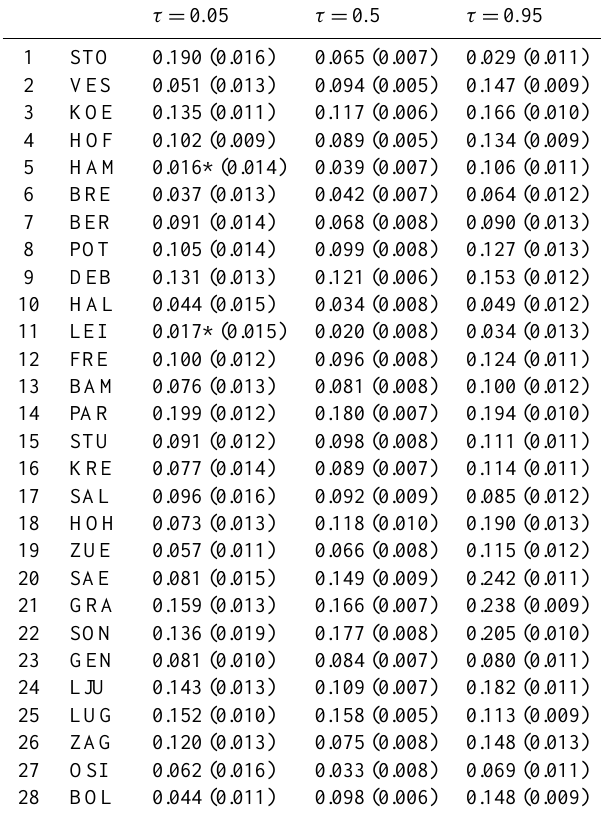
Table 2. Quantile slopes ( ◦ Cdecade − 1 ) and corresponding stan- dard errors (in parenthesis). The sign * denotes values that are not statistically significant (for a 5% significance